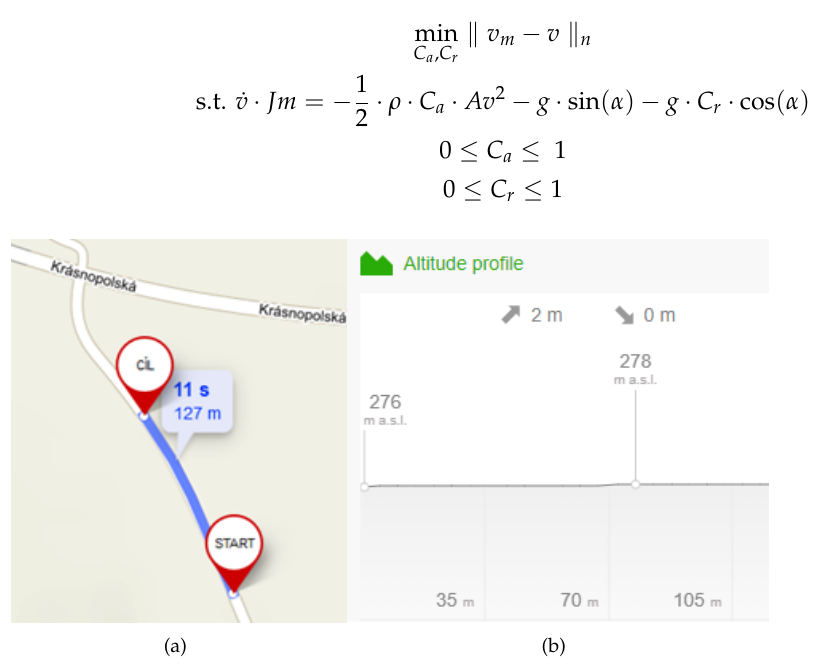
Figure 10. Measured section of the coast down test route ( a ) and its elevation ( b ).